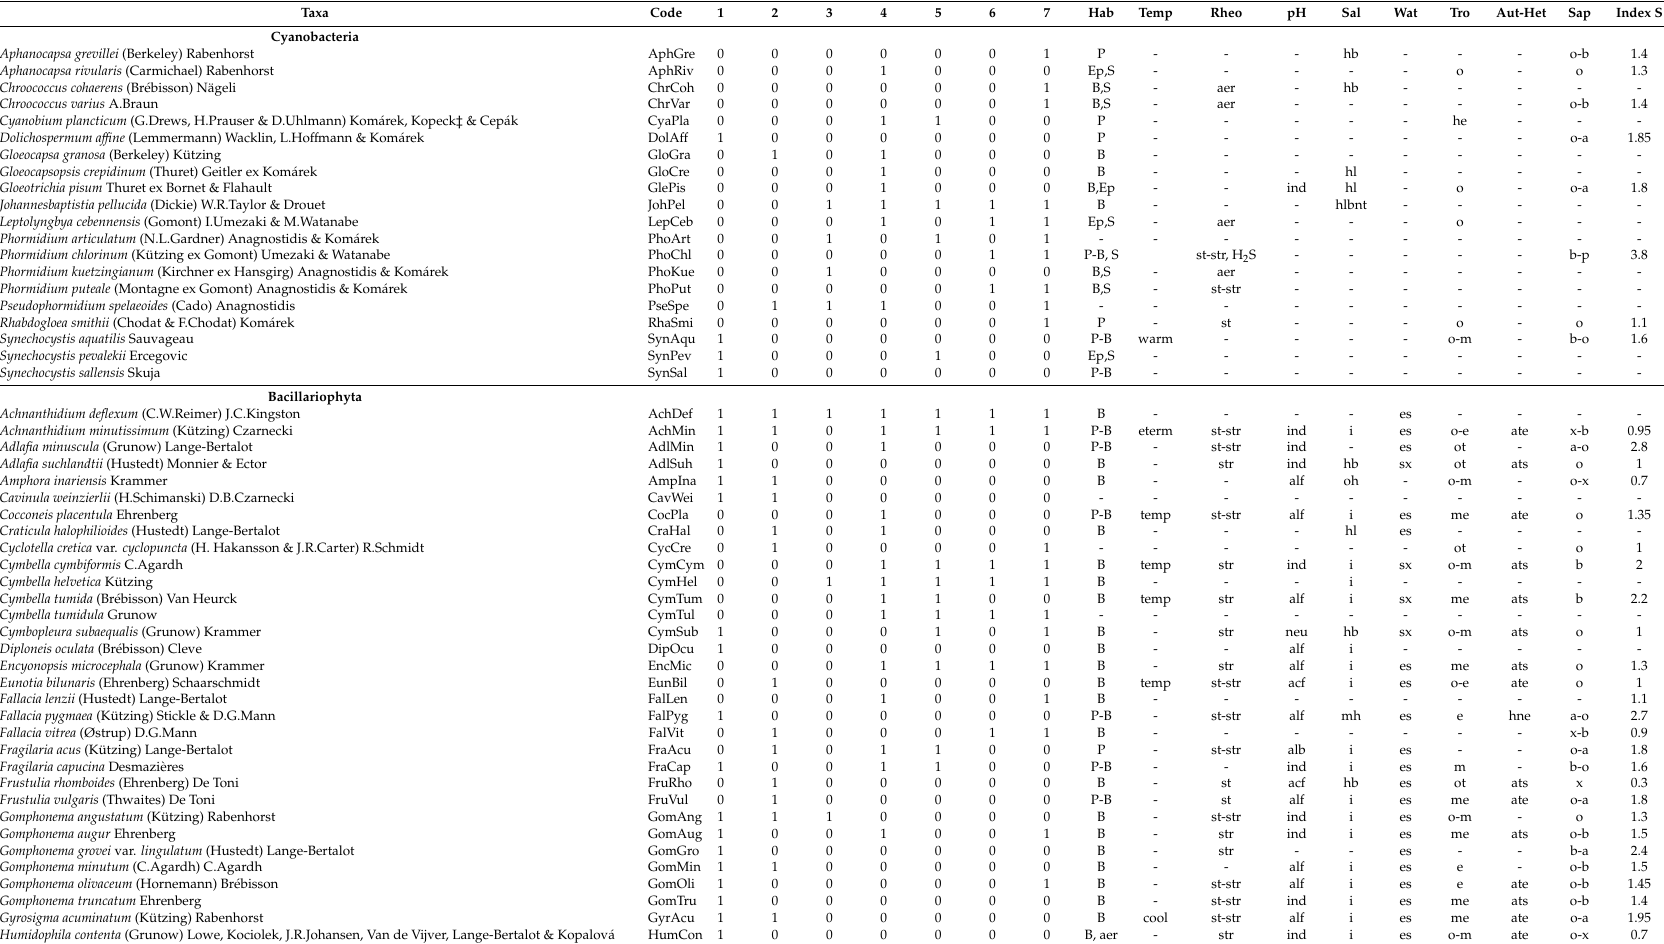
Table 3. Diversity of algae in the Abraham Lincoln Birthplace National Historical Park habitats with the species-specific ecology. Sampling points are given as 1–7 as in Tables 1 and